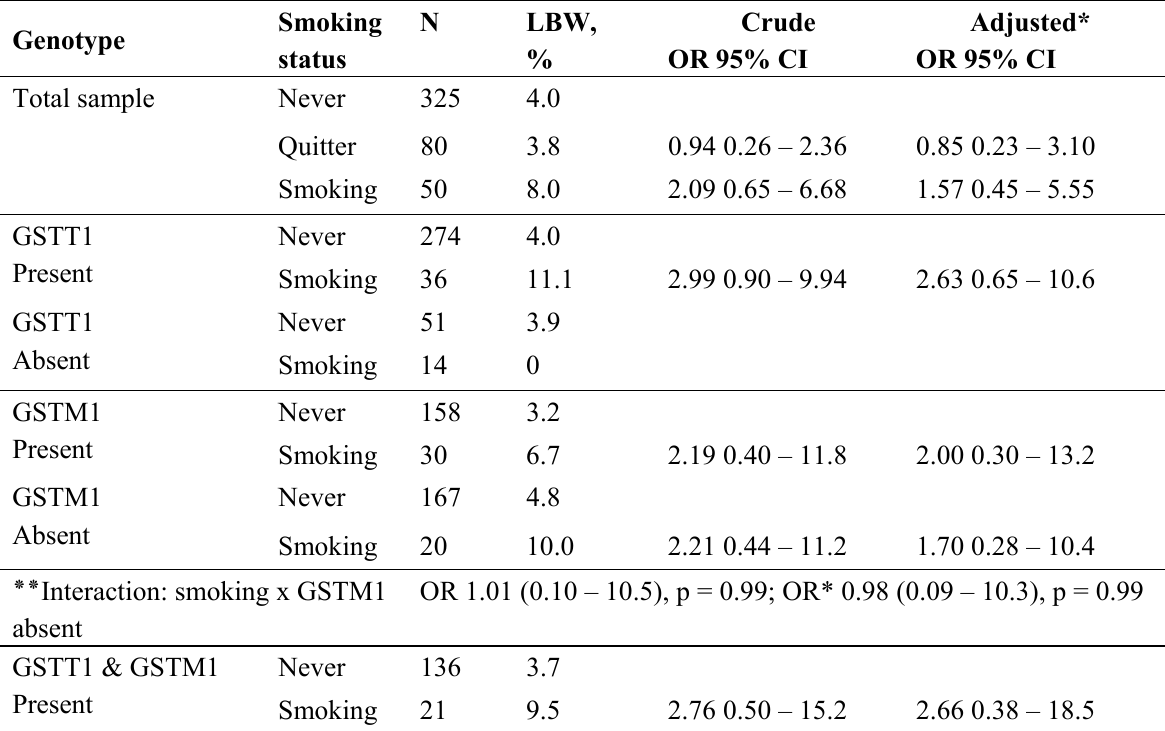
Table 4. Crude and adjusted associations as odds ratios (OR) maternal smoking during pregnancy with intrauterine fetal growth restriction by maternal